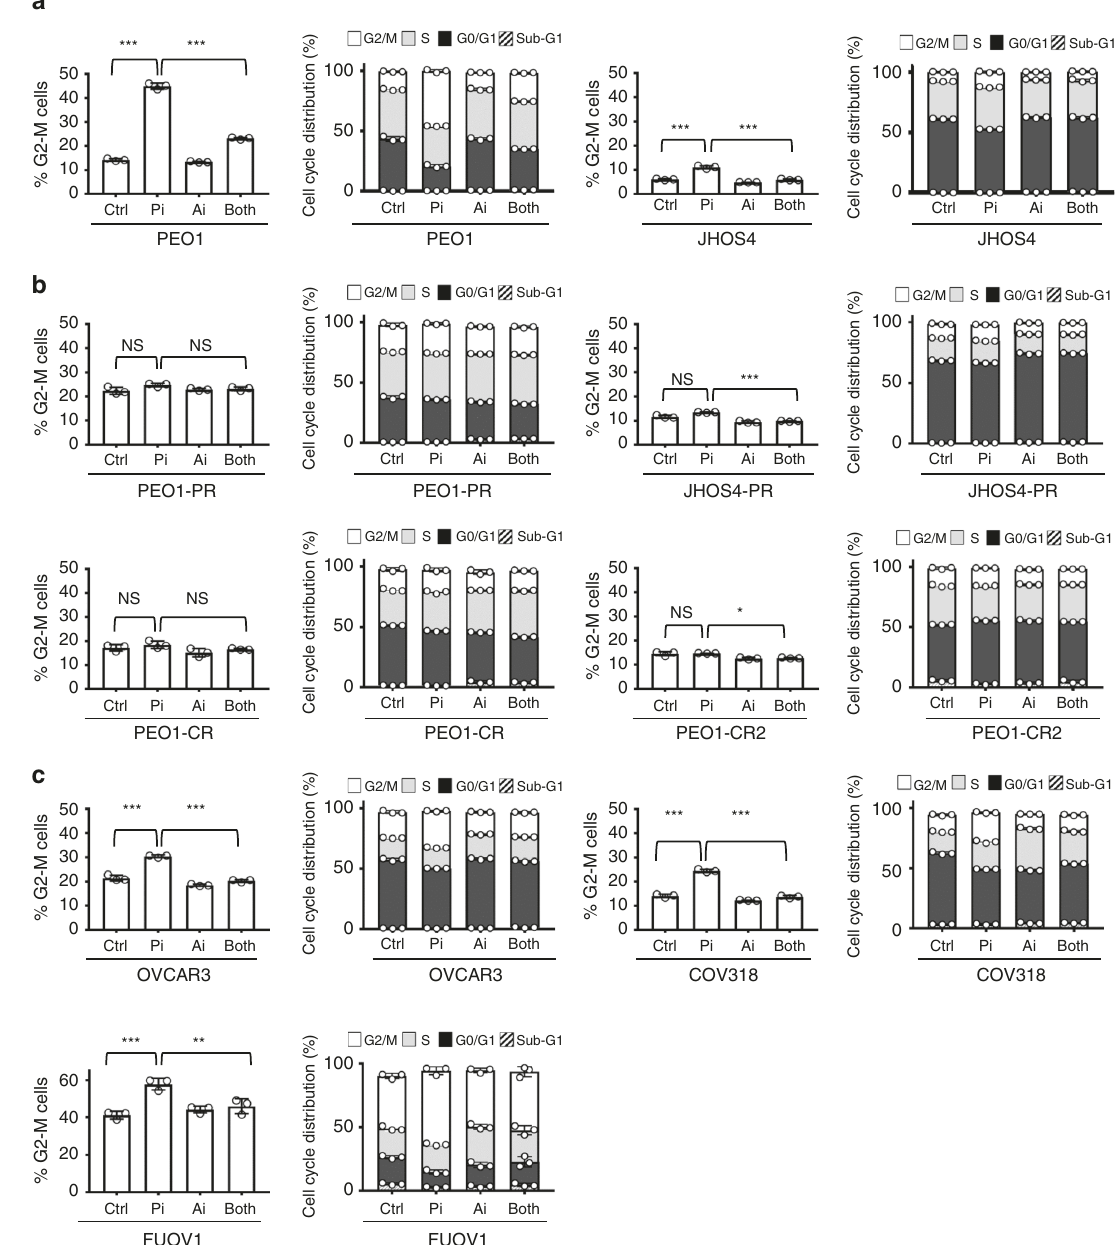
Fig. 3 Treatment effects on cell cycle in acquired PARPi and platinum-resistant cells. a – c Parental BRCA MUT (PEO1, JHOS4) ( a ), acquired PARPi and platinum-resistant (PEO-PR, JHOS4-PR, PEO1-CR, and PEO1-CR2) ( b ), and platinum-resistant CCNE1 AMP (OVCAR3, COV318, and FUOV1) ( c ), cells were treated with PARPi (1 μ M for PEO1, JHOS4, PEO-PR, JHOS4-PR, PEO1-CR, PEO1-CR2, and OVCAR3; 2 μ M for COV318 and FUOV1) and ATRi (1 μ M for